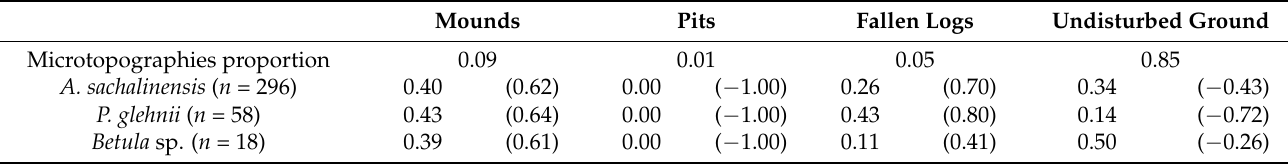
Table 5. Area proportion of microtopographies in the 0.24 ha subplot, and the proportion of number of saplings that appeared by microtopography. The Ivlev electivity index ( − 1 corresponds to total avoidance, and 1 shows total preference) are shown in parentheses. Mounds Pits Fallen Logs Undisturbed Ground Microtopographies proportion Betula sp. ( n =